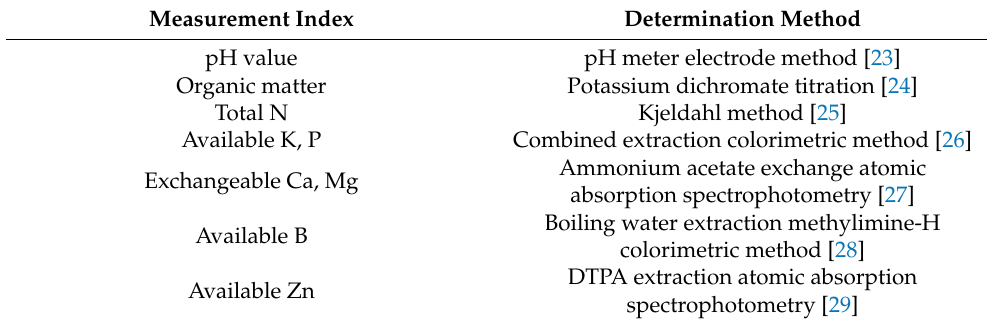
Table 1. Determination indexes and methods of soil nutrients.